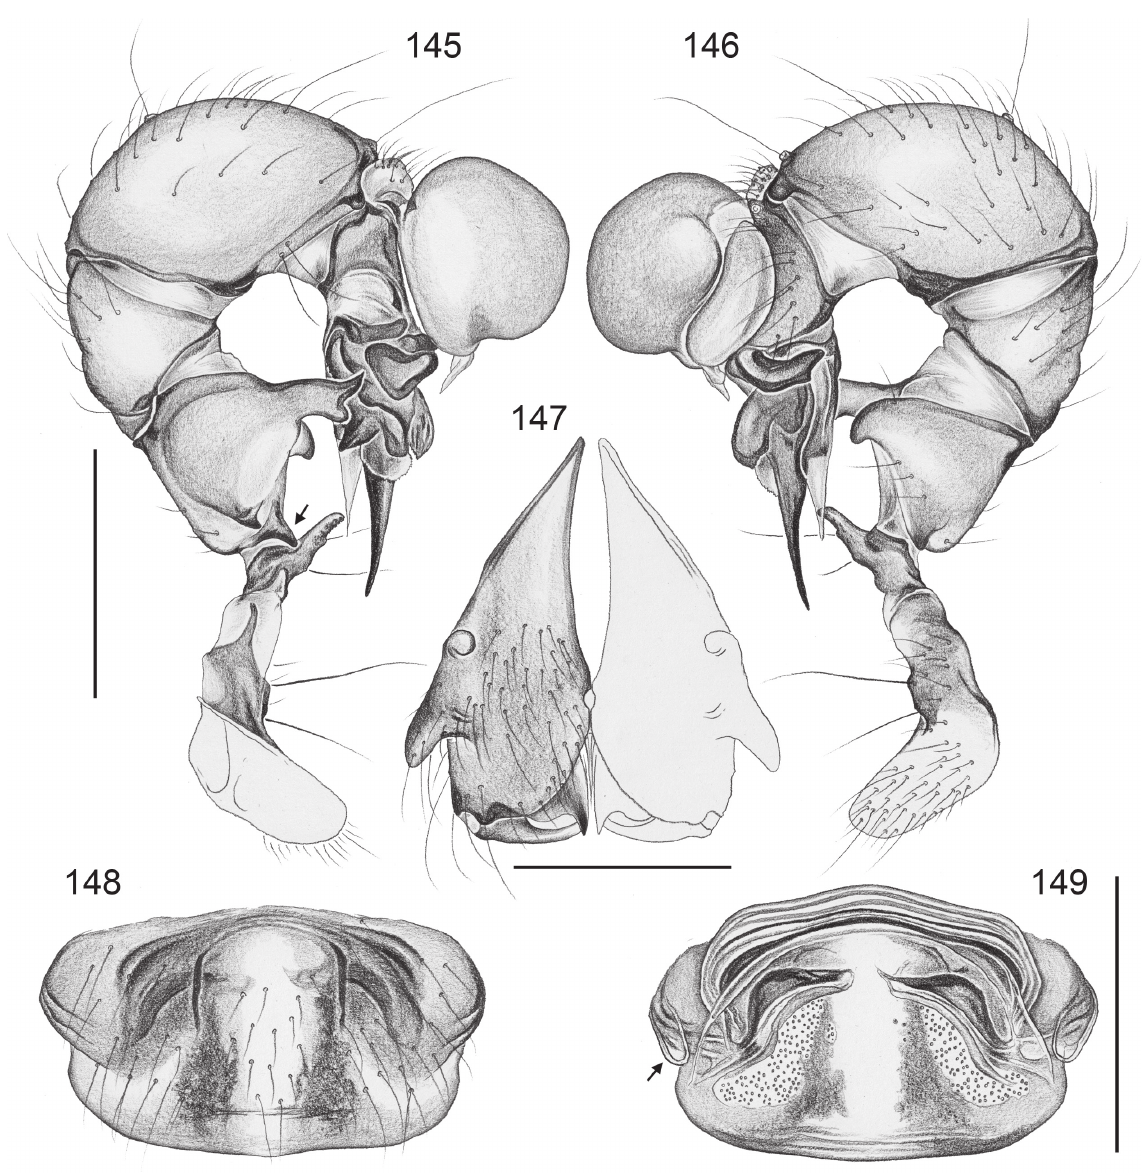
Figs 145–149. Aetana poring Huber, sp. nov. 145–146 . Left male palp, prolateral and retrolateral views (arrow points at prolateral apophysis near hinge). 147 . Male chelicerae, frontal view. 148–149 . Cleared female genitalia, ventral and dorsal views (arrow points at membranous pocket). Scale lines: 145–146, 148–149 = 0.5 mm; 147 = 0.3